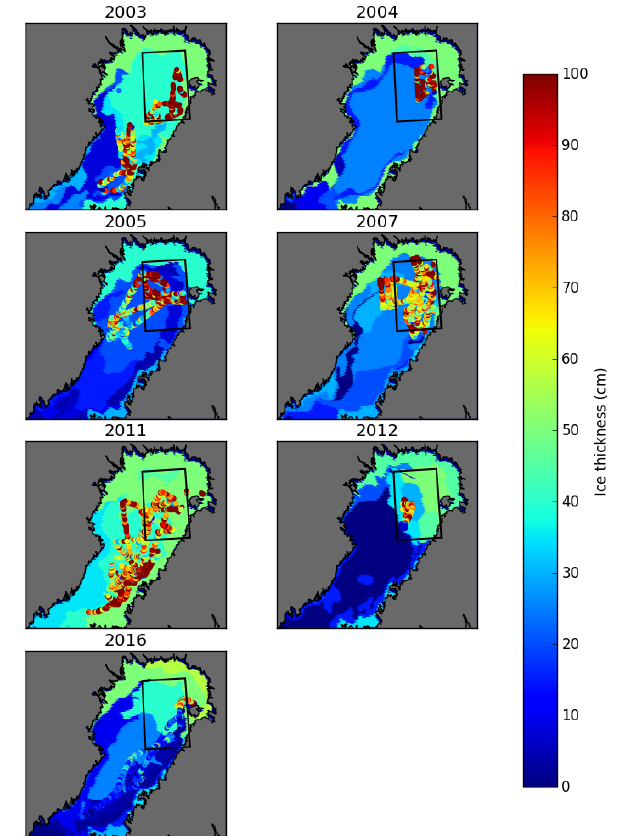
Figure 6. Ice chart (on the background) and 1 nautical mile aver- aged EM data (with dots). Ice charts are from 23 February 2003, 14 March 2004, 13 March 2005, 14 March 2007, 4 March 2011, 21 March 2012, and 5 March 2016. The dates of EM data are in Table 1. As we can see, the ice charts report uniform, thin ice, while in reality thick deformed ice types are typical. The black box is the area west of Hailuoto used in analysis. The limits of the area are in latitude 64.5–65.5 ◦ N and in longitude 23–24.5 ◦